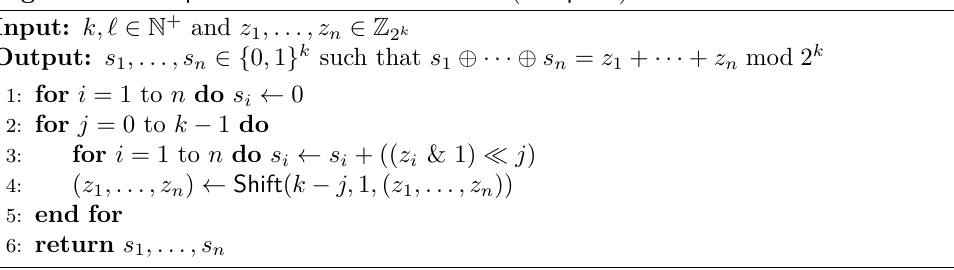
Algorithm 11 Optimized ArithmeticToBoolean ( ABoptiNI